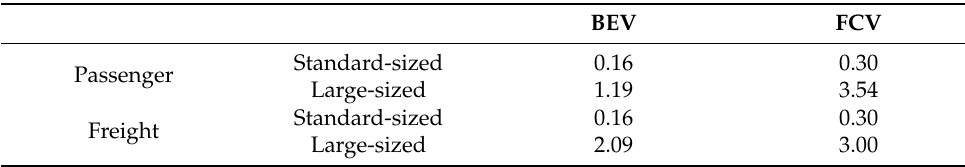
Table 1. Tank-to-wheel efficiency of each type of vehicle